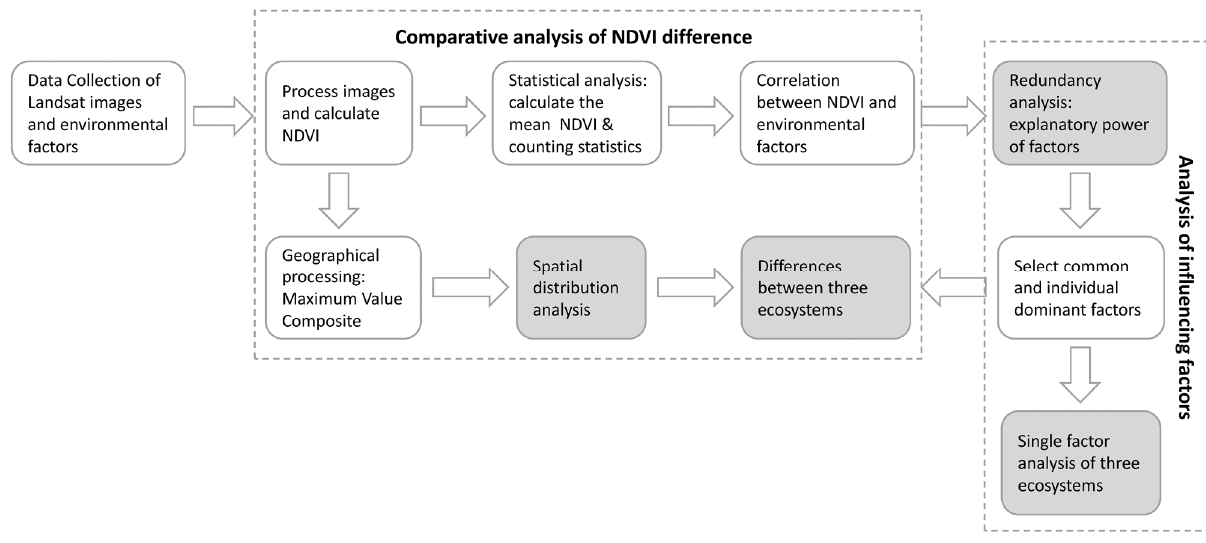
Figure 2. The work fl ow of the research. Figure 2. The workflow of the